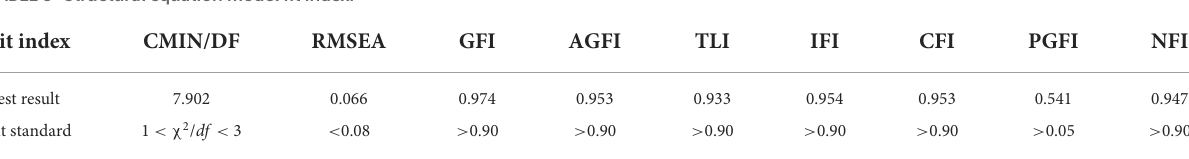
TABLE 5 Structural equation model fit